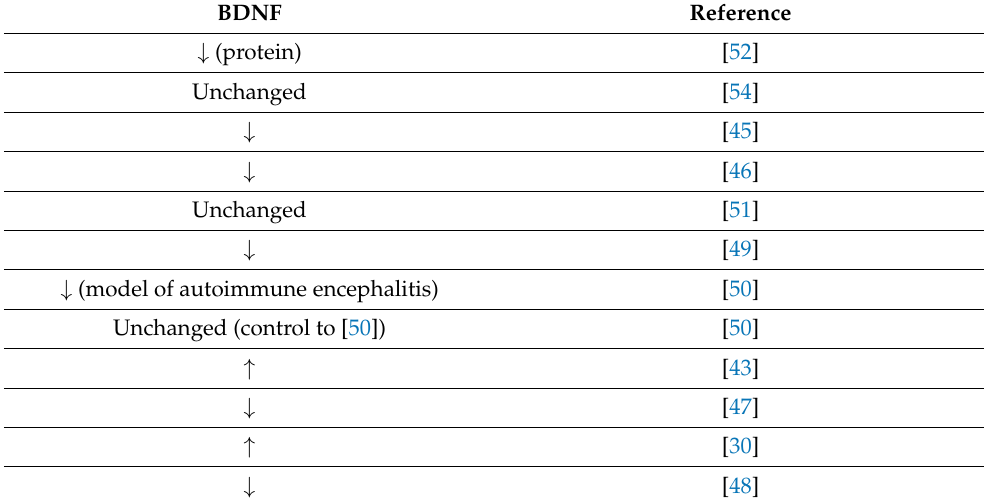
Table 2. Germ-free mice and